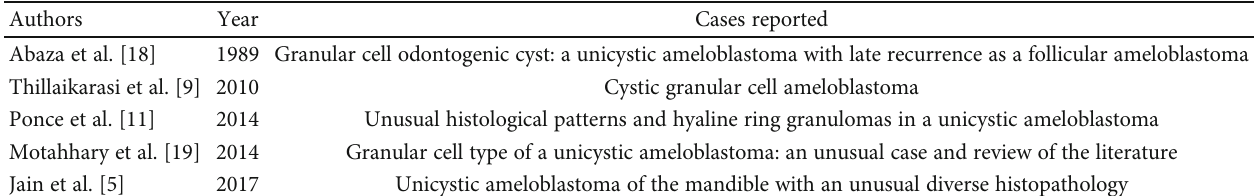
Table 1: List of cases